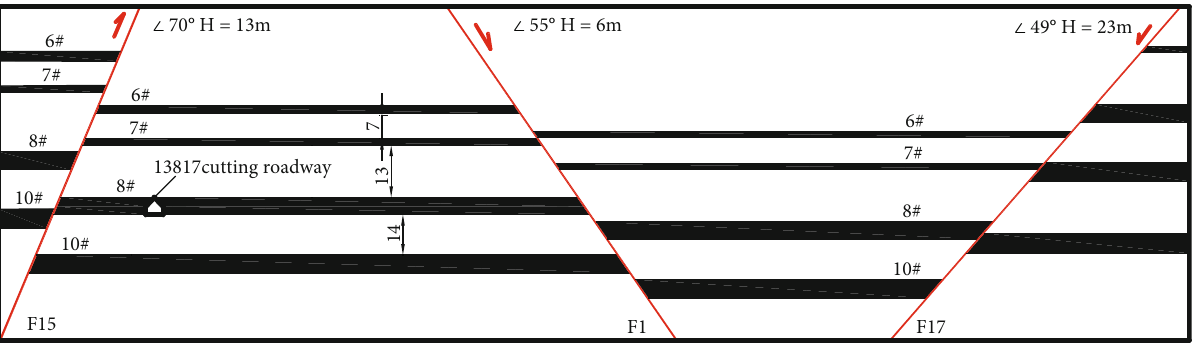
Figure 4: Schematic section of the working face along A-A ′ strike. Table 1: Main parameters of the fault.